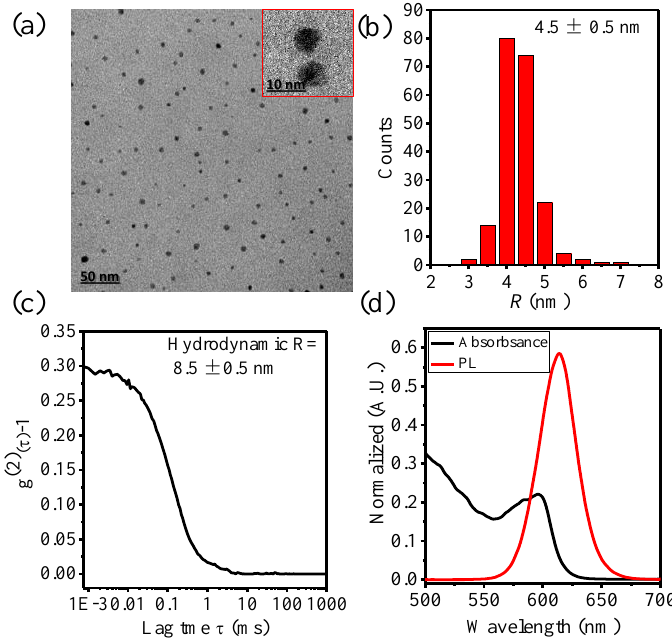
Figure 1. ( a ) Typical transmission electron microscopy (TEM) image and ( b ) the corresponding particle size distributions of carboxyl ZnS/CdSe quantum dots (QDs-COOH); ( c ) Dynamic light scattering (DLS) correlation curves of QDs-COOH; and ( d ) fluorescence emission spectra and ultraviolet-visible spectroscopy (UV-VIS) spectra of QDs-COOH. Table 1. List of measured hydrodynamic R and zeta potentials ( ζ ) of different QDs at different pH (6.0, 7.4, and 9.0).